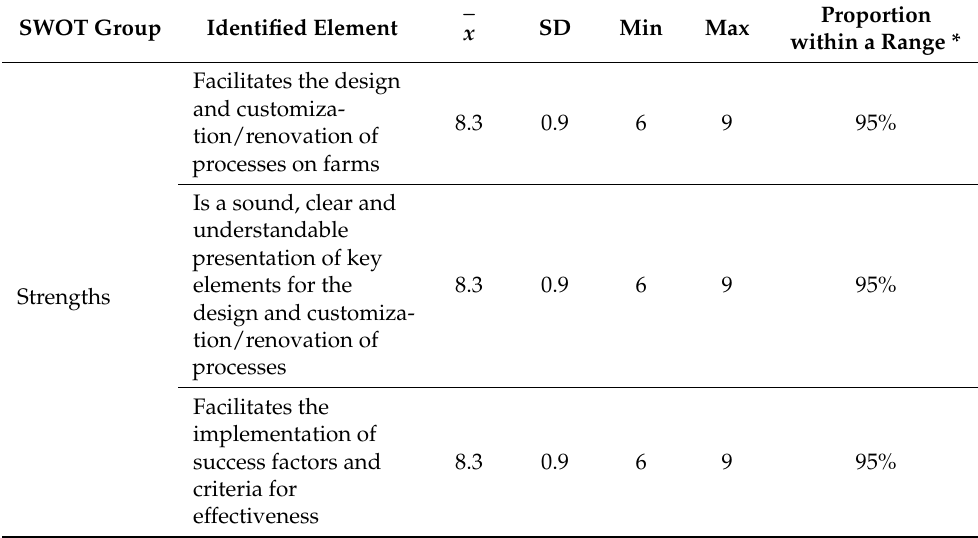
Table 3. Identified elements by SWOT groups in the first round and the corresponding mean value, SD, minimum, maximum, proportion within the range of the responses after the second